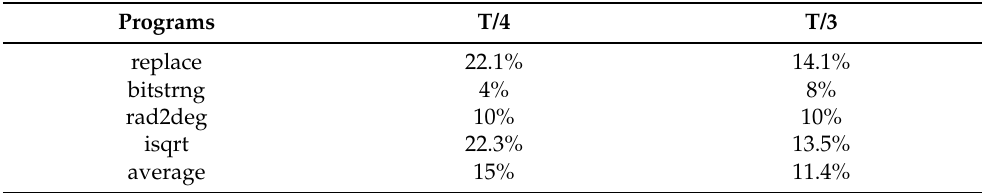
Table 2. The results of ep